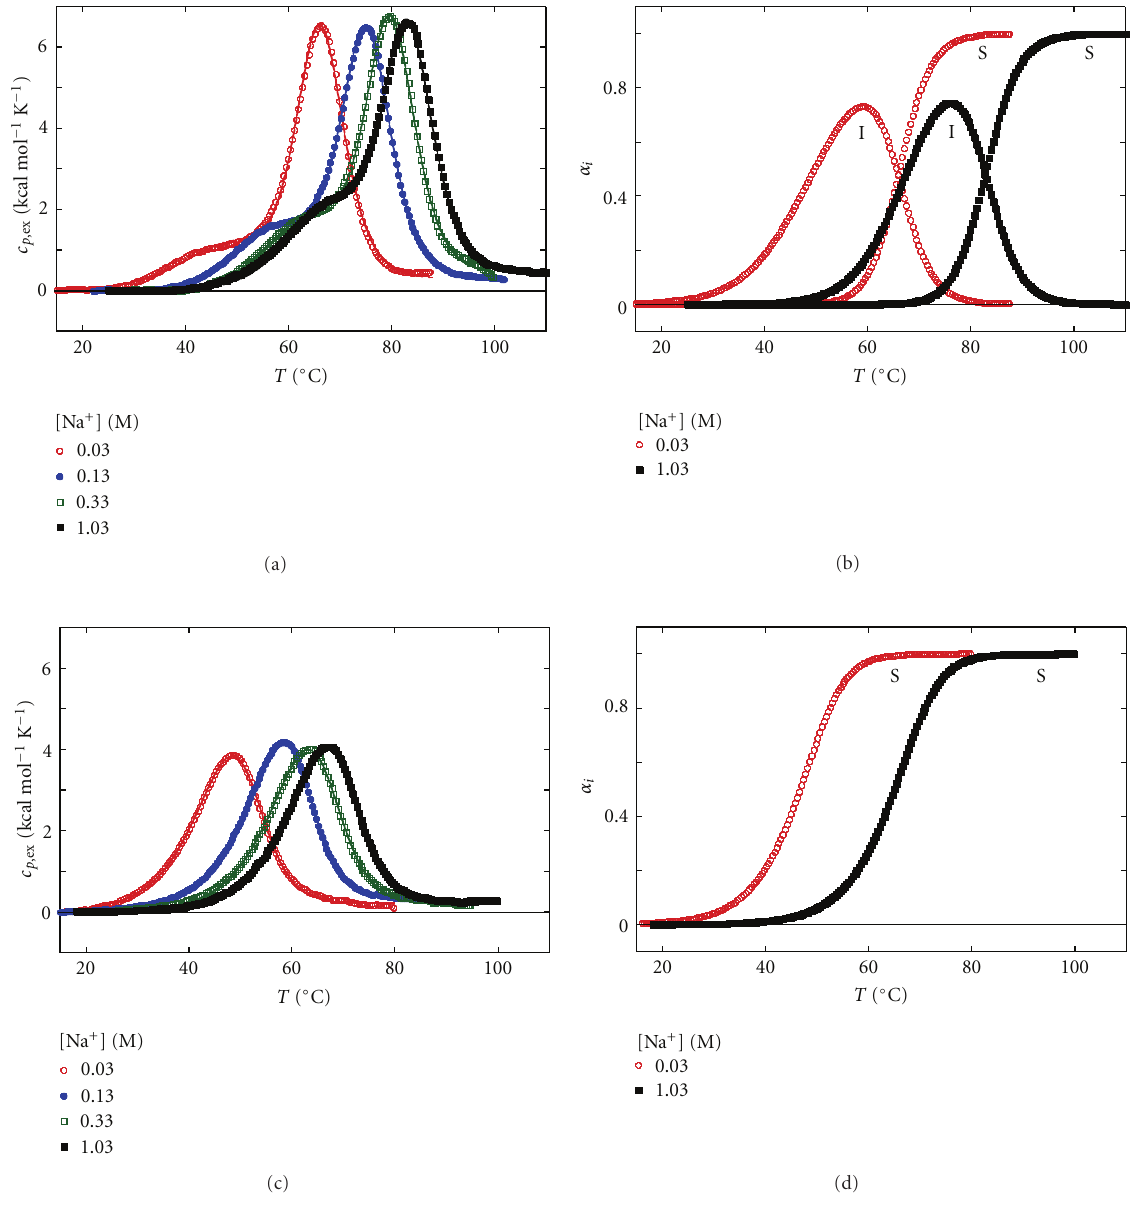
Figure 2: DSC thermograms and their model analysis: hairpin (HP) unfolding characterized in terms of a three-state model HP ↔ I ↔ S (a) and the corresponding fractions of species (b); duplex (D) unfolding characterized in terms of a two-state model D ↔ 2S (c) and the corresponding fractions of species (d). In panels (a) and (c) symbols represent experimental data points while lines of the same color correspond to the best-fit model functions ((14) and